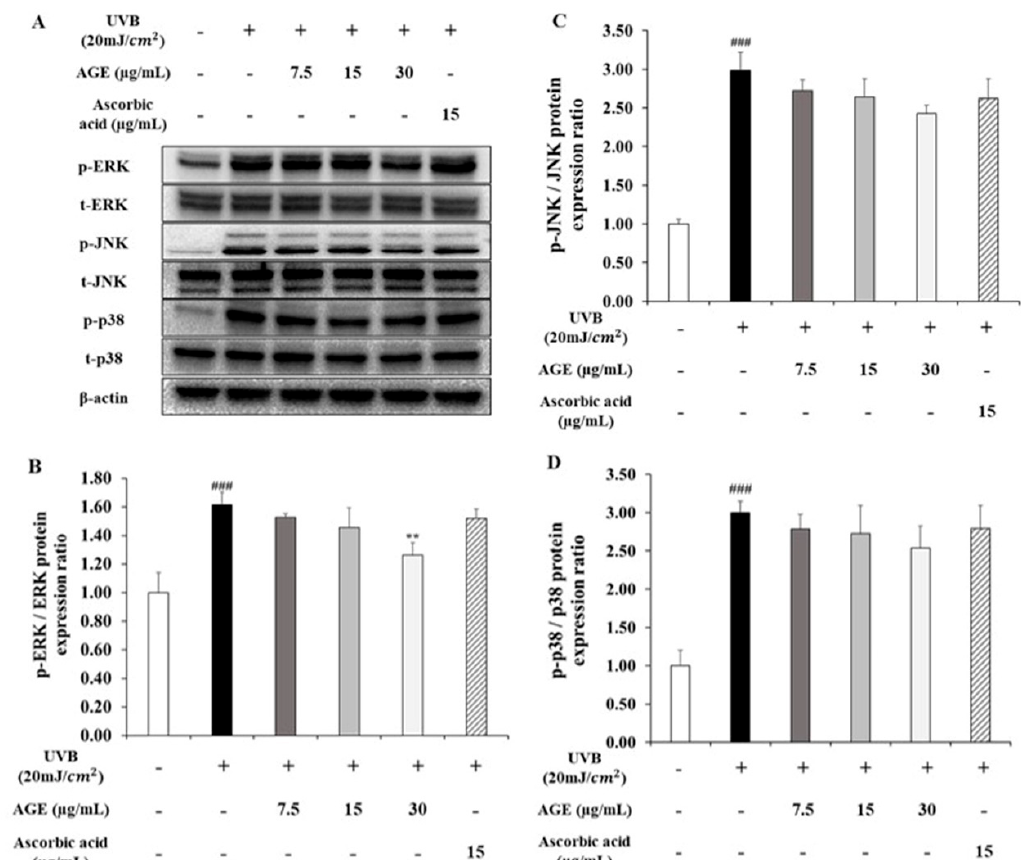
Figure 4. Effects of AGE on MAPK signaling pathway in UVB-irradiated HDFs. HDFs were irradiated with UVB (20 mJ/cm 2 ), followed by treatment with 7.5, 15, and 30 µg/mL of AGE. After 24 h incubation, protein extraction was performed. Phosphorylation and total protein ratios of ERK ( B ), JNK ( C ), and p38 ( D ) were measured using Western blot ( A ). All data were expressed as the mean ± SD of at least three independent experiments. ### p < 0.001 versus untreated cells, ** p < 0.01 versus UVB-irradiated cells.